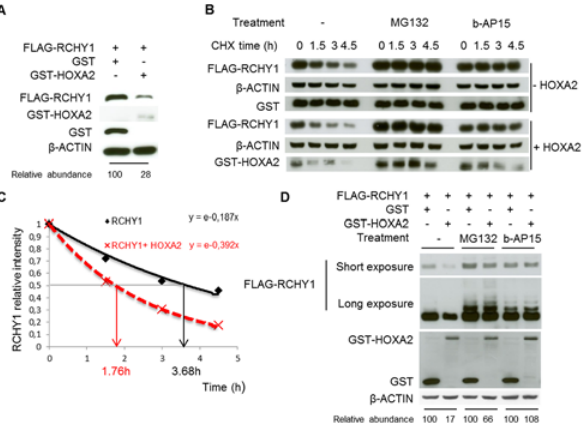
Fig 1. HOXA2 reduces RCHY1 half-life in a 26S proteasome-dependent way. (A-B-D) HEK293T cells were cotransfected with expression vectors coding for FLAG-RCHY1 and GST-HOXA2 or GST. Cell lysates were then subjected to immunoblot analysis with antibodies against FLAG, GST and β -ACTIN. The relative RCHY1 abundance was determined with regards to that of β -ACTIN. (B) To determine the RCHY1 half-life in the absence (-HOXA2) or in presence (+HOXA2) of HOXA2, cells were treated with cycloheximide (CHX) for the indicated time. The involvement of the proteasome in the RCHY1 degradation was assayed by treating cells with proteasome inhibitors (MG132 or b-AP15) for 4 hours prior to inhibition of protein translation with CHX. (C) The intensity of the RCHY1 and β -ACTIN bands observed upon cycloheximide treatment, without proteasome inhibition, was quantified and the relative RCHY1/ β -ACTIN ratios were plotted. (D) The involvement of the proteasome in the HOXA2-induced RCHY1 degradation was assayed by treating cells